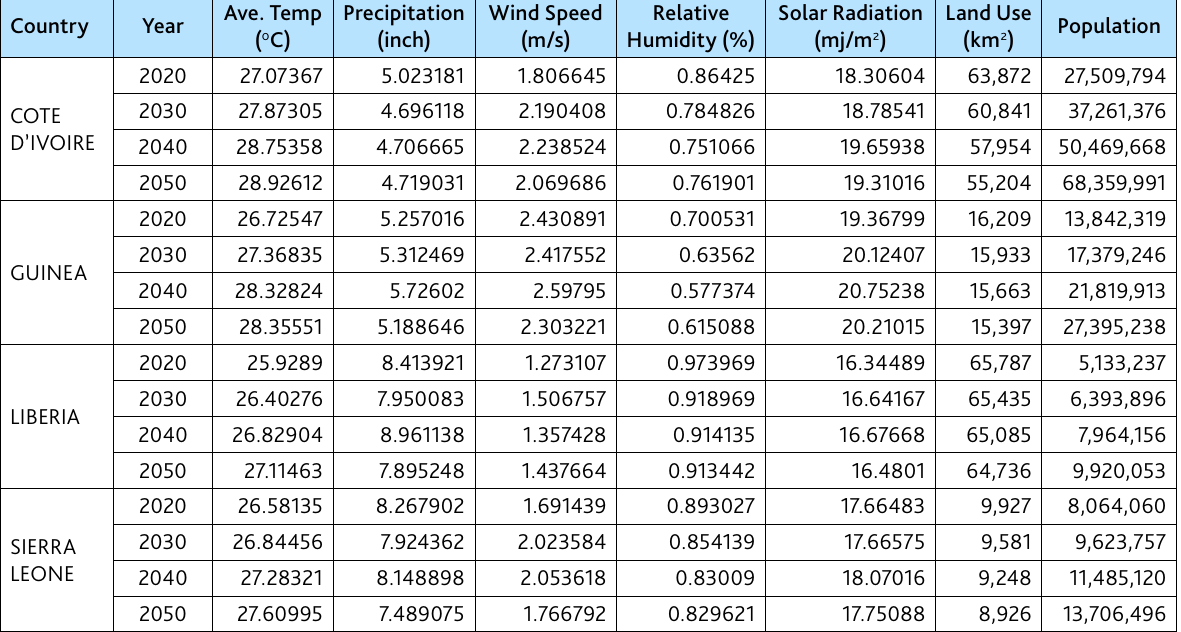
Table 4. Summary of